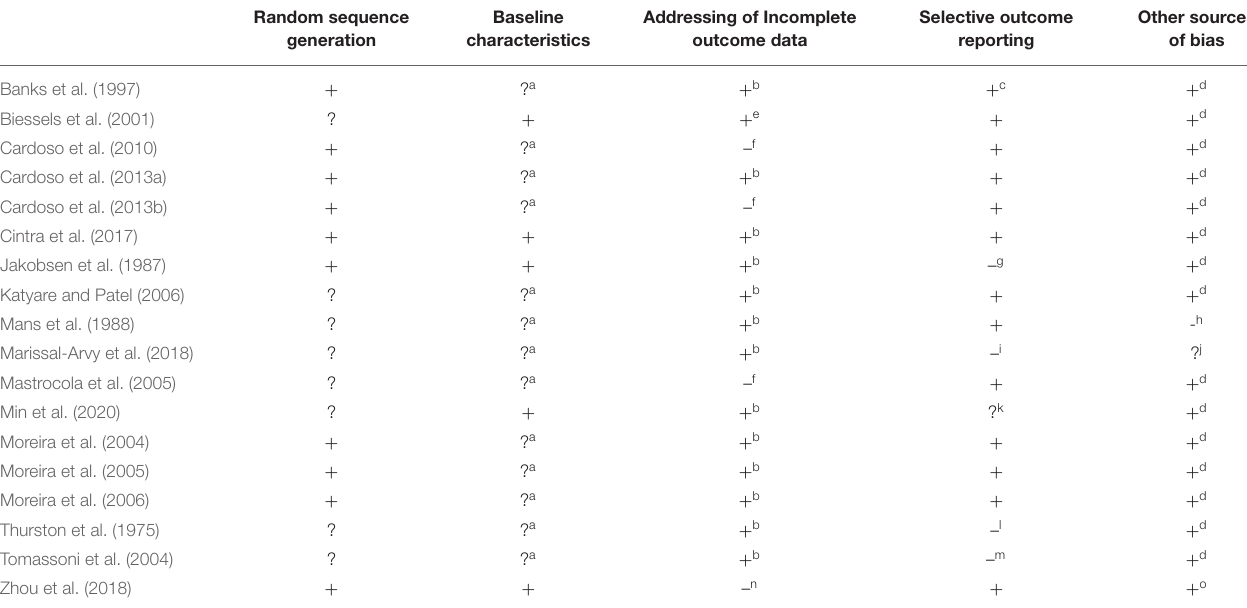
TABLE 2 | Risk of bias